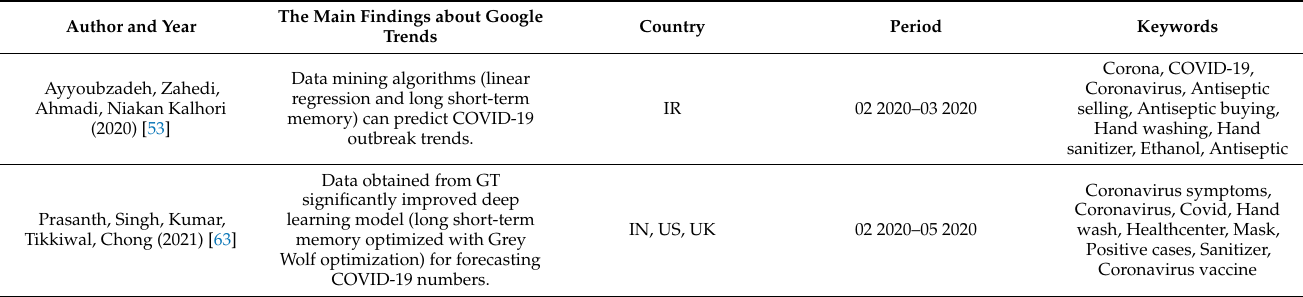
Table 2. Publications where GT data were analyzed using more complex